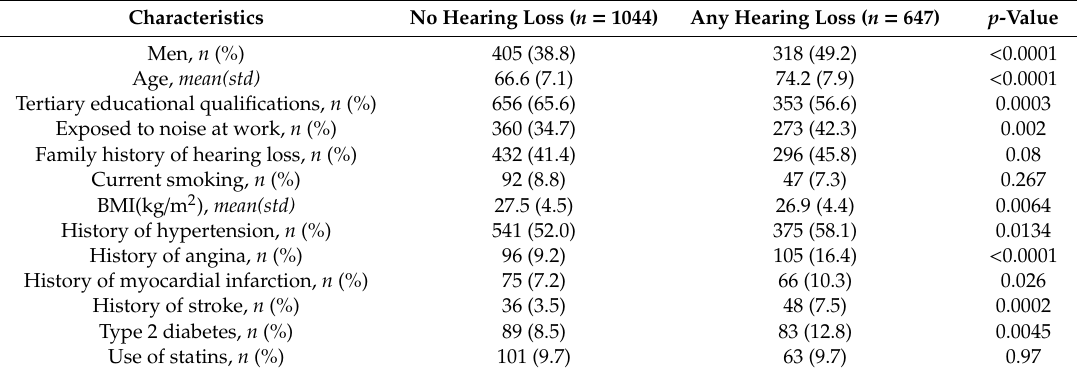
Table 1. Characteristics of Blue Mountains Hearing Study participants stratified by hearing status at